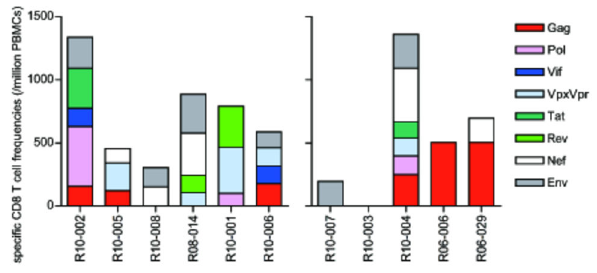
Figure 5. SIV antigen-specific CD8 + T-cell responses. SIV Gag-, Pol-, Vif-, Vpx/Vpr-, Tat-, Rev-, Nef-, and Env-specific CD8 + T-cell responses were measured by detection of antigen- specific IFN-γ induction using PBMCs at weeks 26-30 post- challenge.